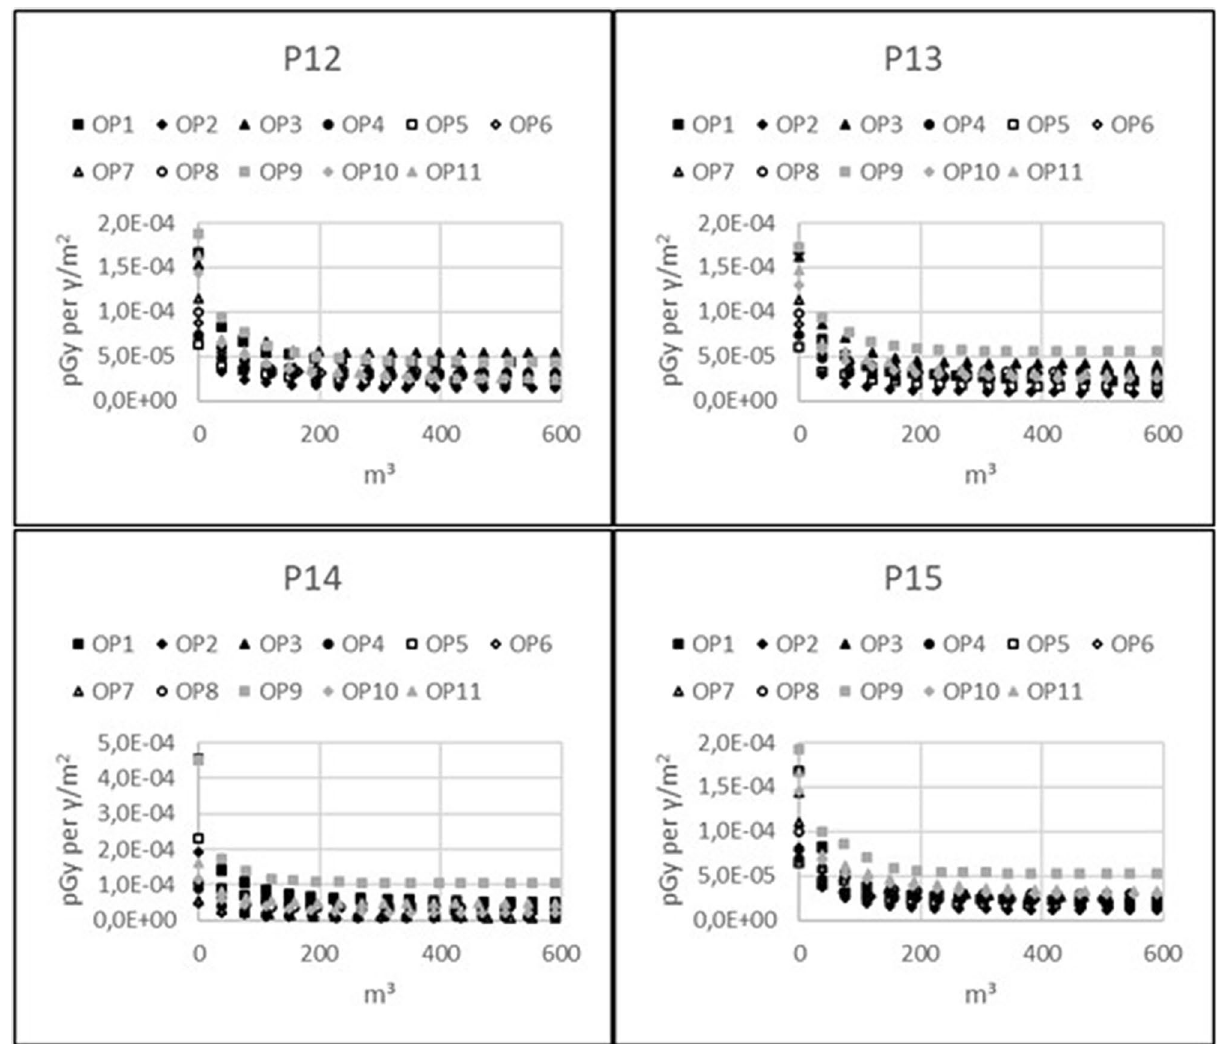
Figure 5. Reduction of absolute radiation exposure per volume of generated waste caused by topsoil removal for 11 observation points inside a wooden house on properties P12–P15.